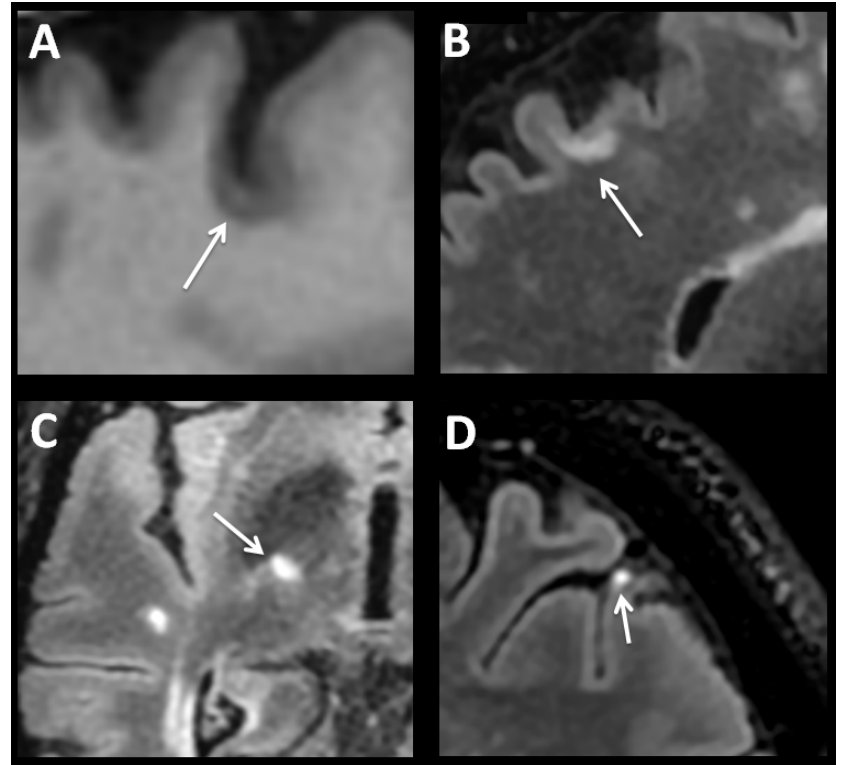
Figure 1. A : Three-dimension sagittal T1-weighted. Hypointense cortical lesion (white arrow). B : Three-dimension sagittal T2-Fluid Attenuated Inversion Recovery (FLAIR). Hyperintense leukocortical lesion (white arrow). C : Axial FLAIR. Subcortical temporal demyelinating plaque and perithalamic internal capsule lesion (white arrow). D: Post-contrast 3D sagittal FLAIR. Focal area of leptomeningeal enhancement (white arrow).